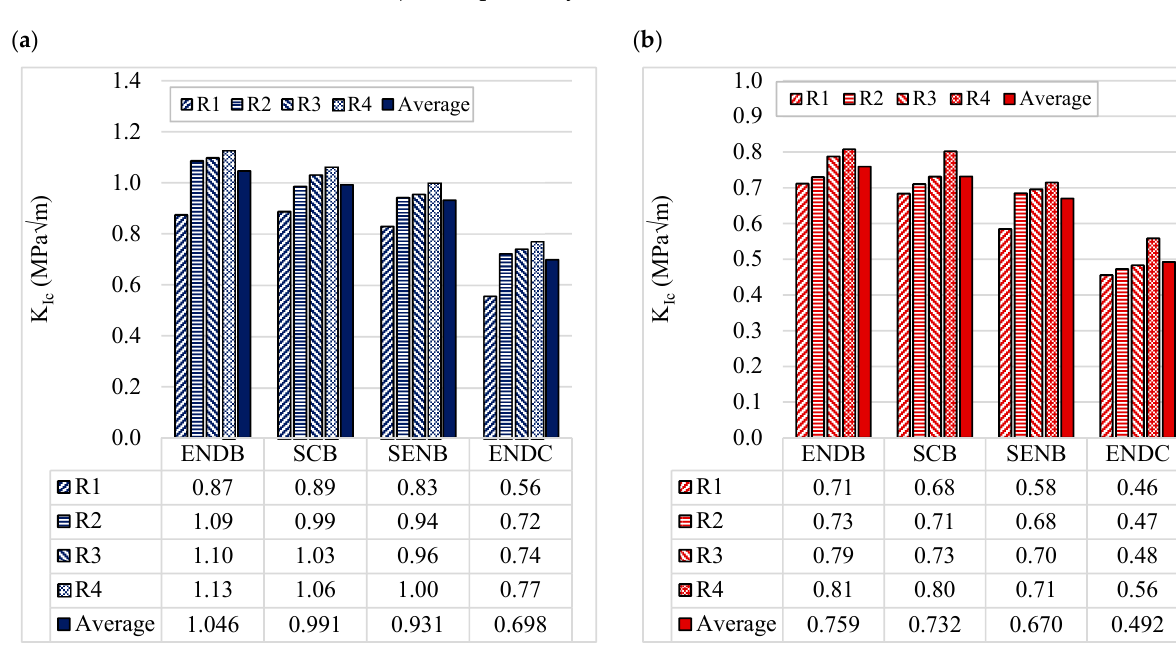
Figure 9. Fracture toughness of tested specimens under different test temperatures: ( a ) − 25 °C and ( b ) − 5 °C.